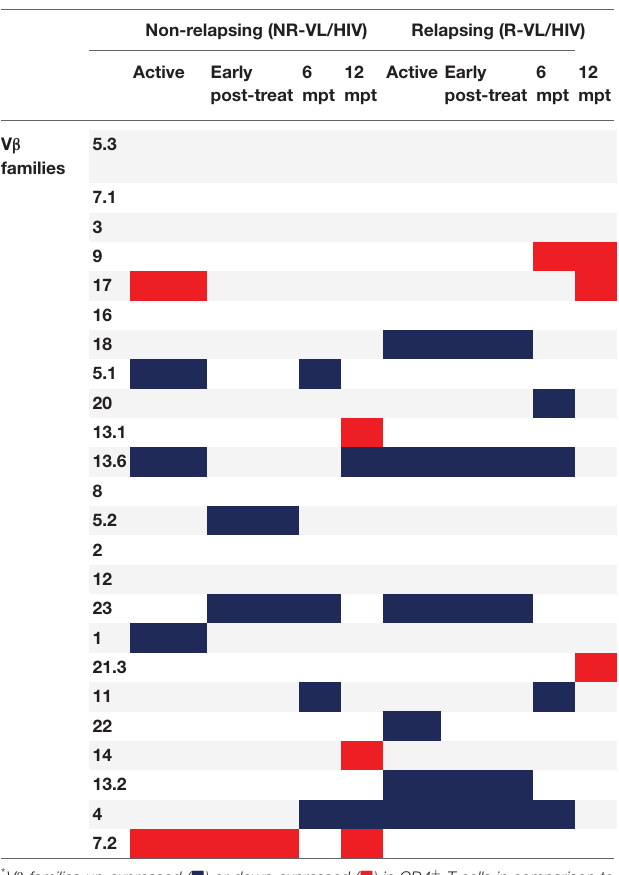
TABLE 2 | Differences in the CD4 + T-cell V β repertoire mobilization profile of non-relapsing and relapsing visceral leishmaniasis/HIV (VL/HIV) co-infected patients.